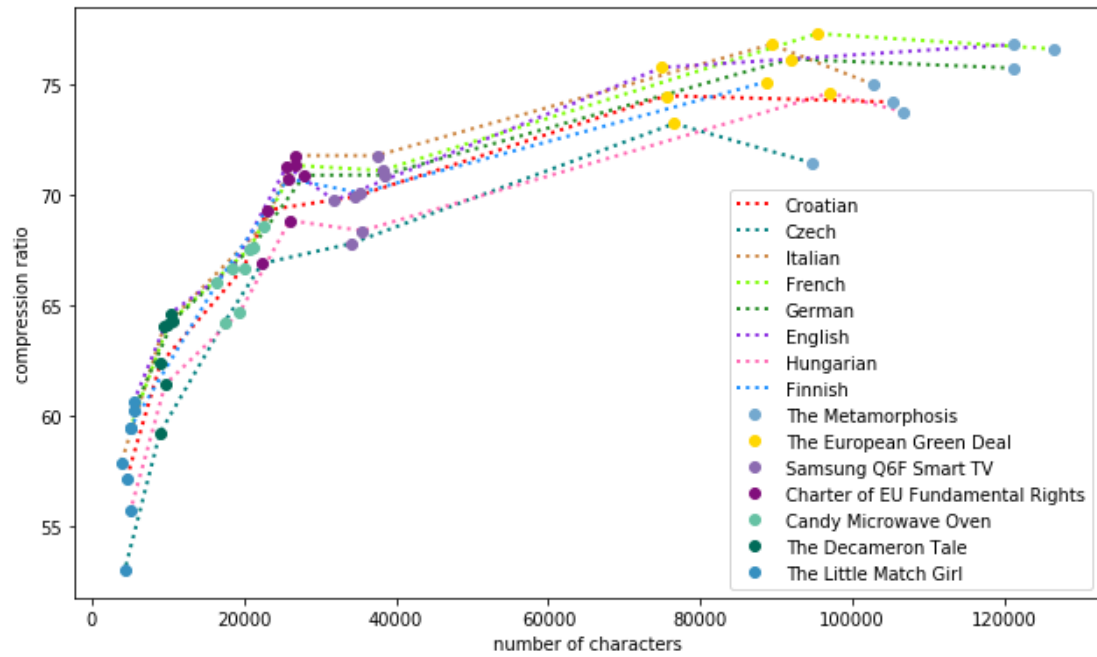
Figure 14. LZW compression results—text length